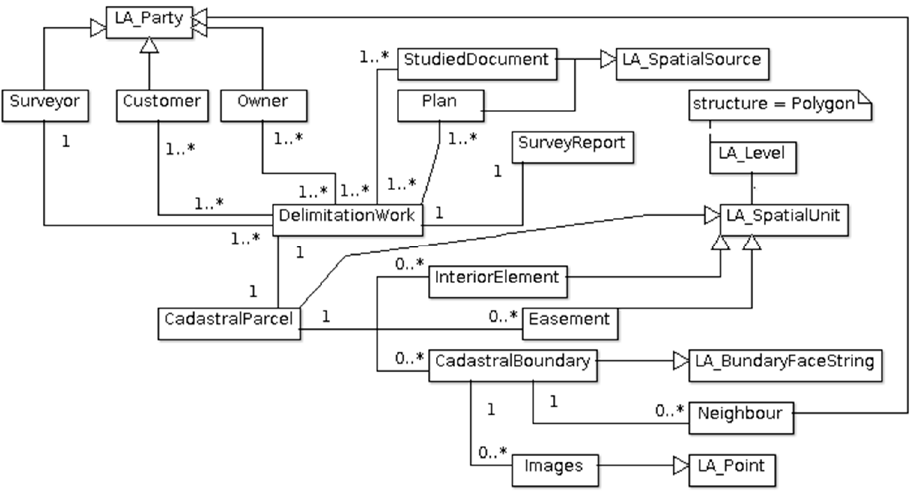
Figure 10. UML class diagram of TopoDelProp. Source: own elaboration.